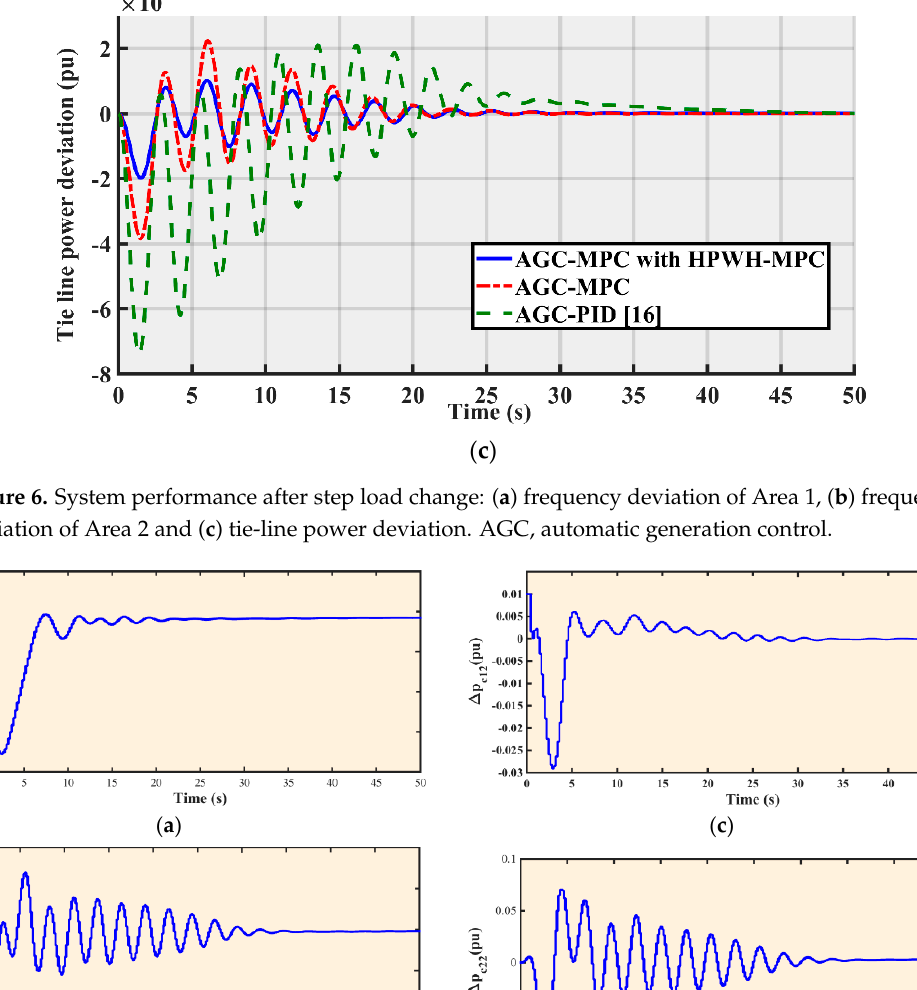
Table 2. Peak overshoot, peak time and settling time for the controllers in the first scenario.